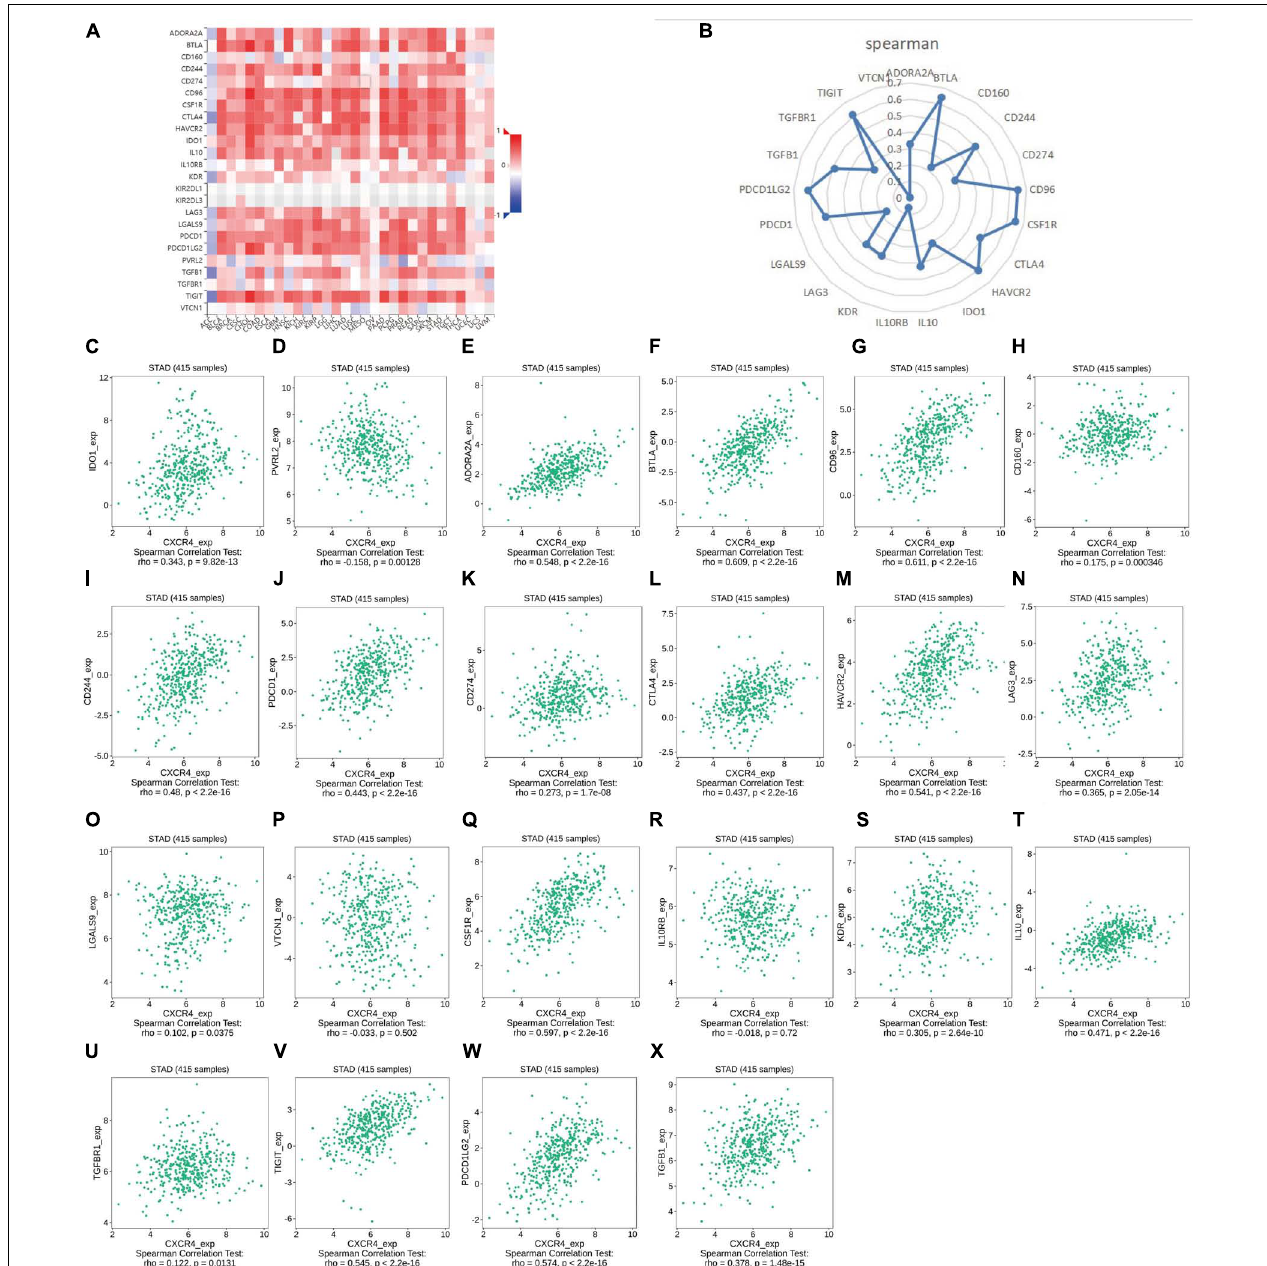
FIGURE 10 | Correlation analysis of the expression of CXCR4 expression with that of immune checkpoint genes. (A,B) Correlation analysis of the expression levels of CXCR4 with those of 22 common immune checkpoint genes in gastric cancer. (C–X) The relationship between the expression of CXCR4 with that of IDO1 , PVRL2 , ADORA2A , BTLA , CD96 , CD160 , CD244 , PDCD1 , CD274 , CTLA4 , HAVCR2 , LAG3 , LGALS9 , VTCN1 , CSF1R , IL10RB , KDR , IL10 , TGFBR1 , TIGIT , PDCD1LG2 , and TGFB1 .